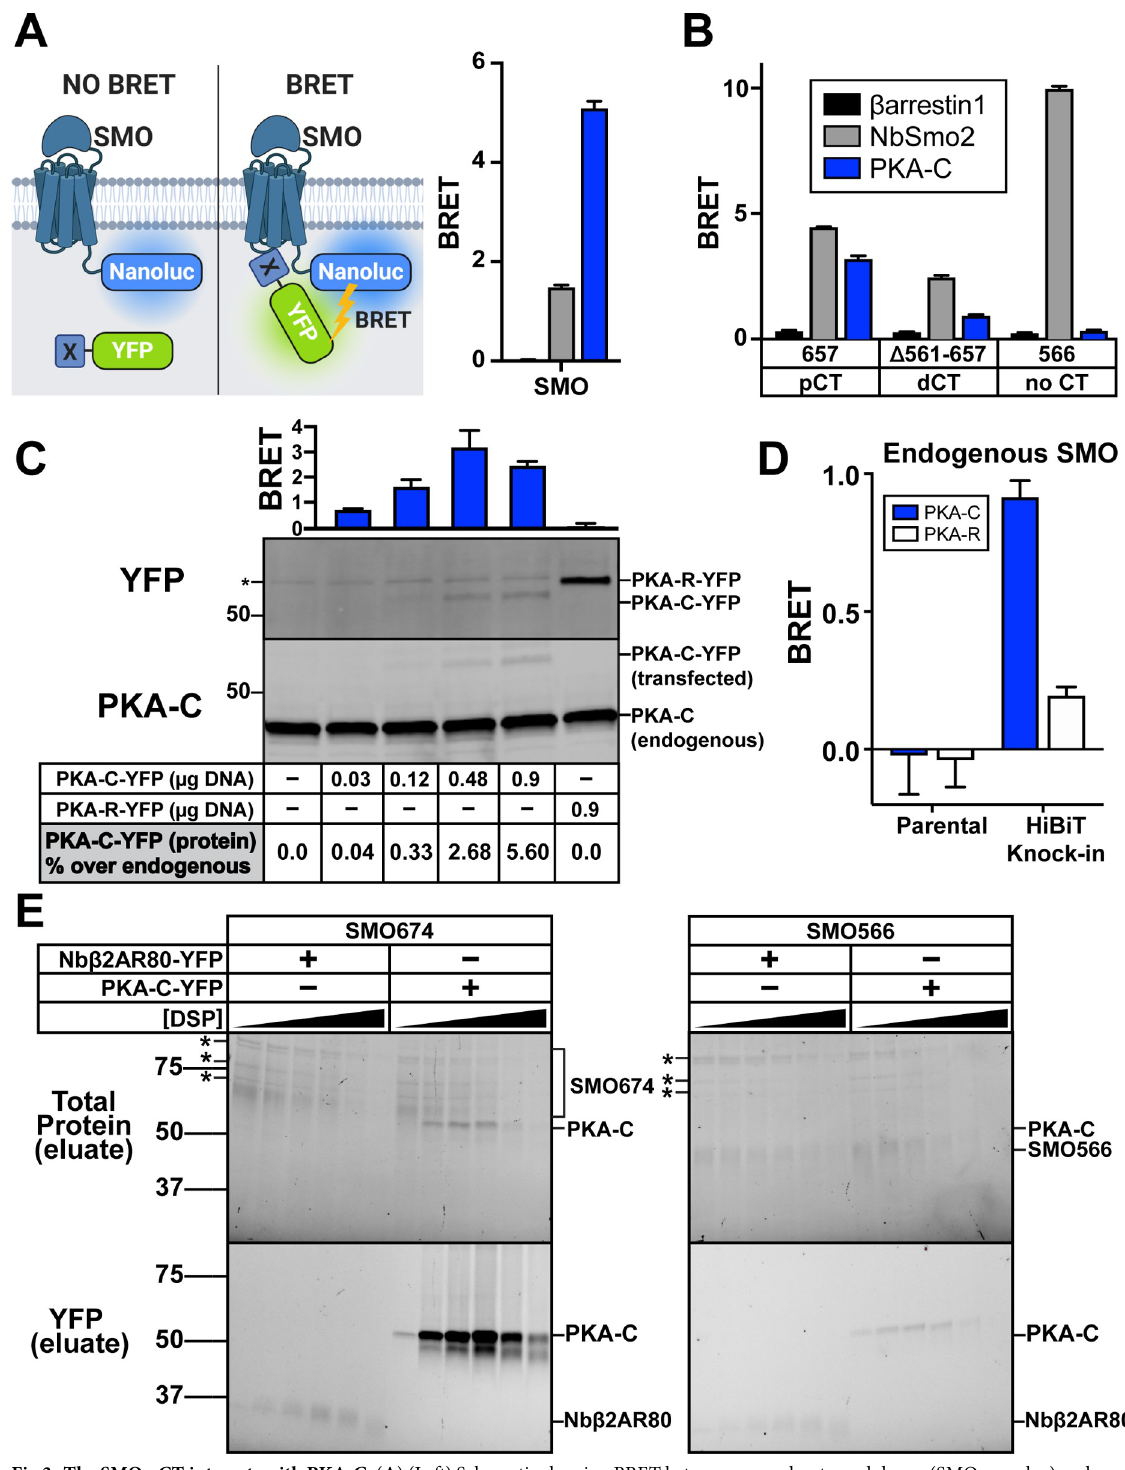
Fig 3. The SMO pCT interacts with PKA-C. ( A ) (Left) Schematic showing BRET between a nanoluc-tagged donor (SMO-nanoluc) and a YFP-tagged acceptor. (Right) HEK293 cells were transfected with nanoluc-tagged full-length SMO, along with YFP-tagged β arrestin1 (black), NbSmo2 (gray), or PKA-C (blue) and subject to BRET analysis. ( B ) HEK293 cells were transfected with nanoluc-tagged SMO657 (which contains the pCT), SMO Δ 561–657 (which contains the dCT), or SMO566 (which lacks the CT entirely) as donors, along with the indicated acceptors. Color codes are the same as in (A). Note that NbSmo2 binding does not require the SMO CT (see S2 Fig ). In fact, NbSmo2